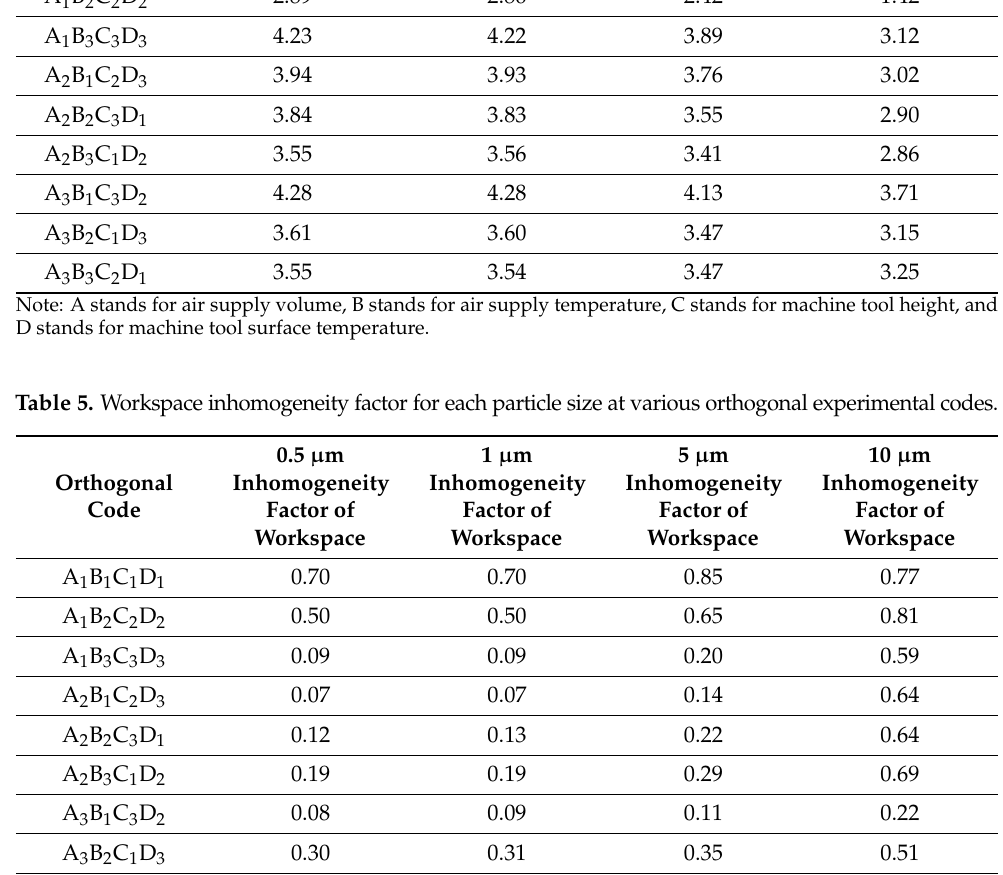
Table 4. Stratification height for each particle size at various orthogonal experimental codes. Orthogonal Code